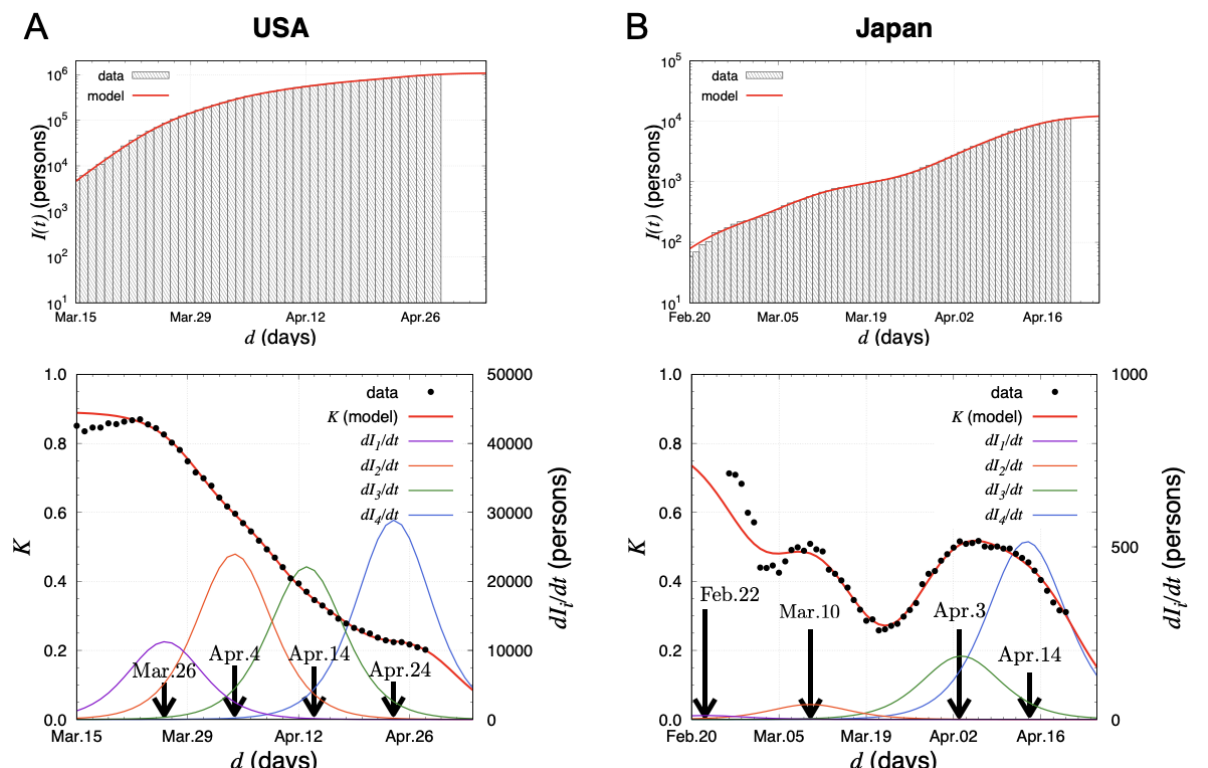
Figure 3. The model results of the total number of infected people and the K value in (A) the United States and (B) Japan. (A) The fit results are given in the top figure. The K value is represented together with the daily new cases dI i /dt calculated in the susceptible-infected model at the bottom. The peak positions tci caused by the source i (i=1,2,3,4) are shown by the vertical allows. (B) Same as (A) for the case of Japan. The reference date of February 19 was kept for the K